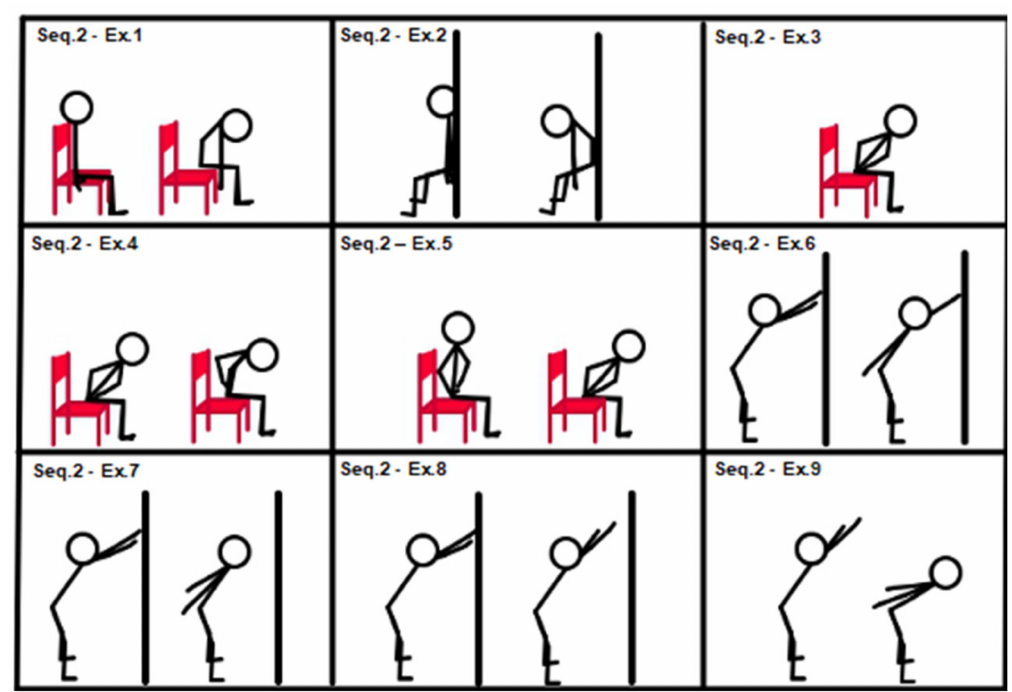
Figure 2. Sequence 2: trunk, entry